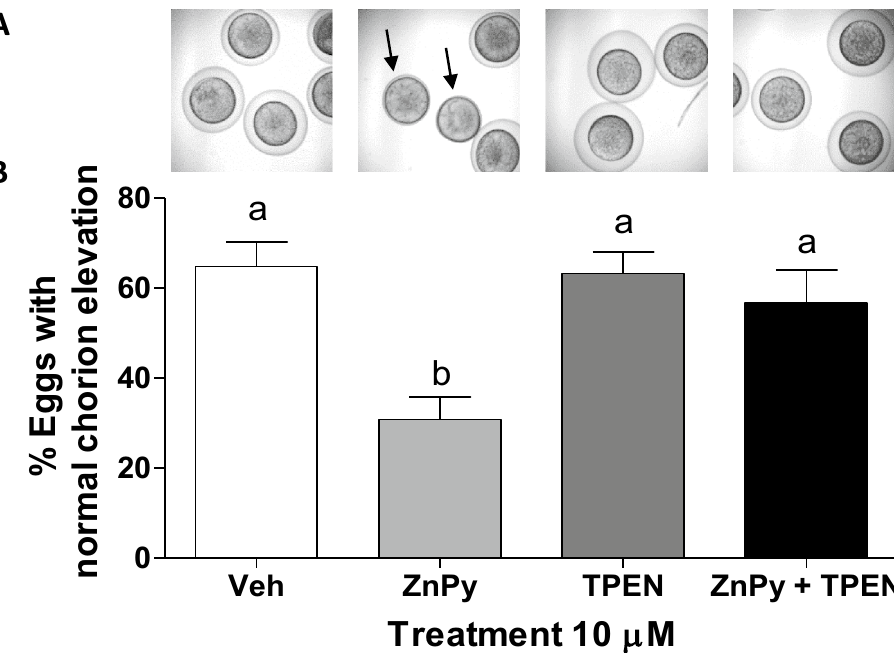
Figure 7. Effect of sustained zinc elevation on chorion elevation. (A) Representative micrographs of the effects of pre-treatment with zinc pyrithione (ZnPy) and TPEN on meiosis II-arrested eggs 10 min post-activation. (B) Quantification of ZnPy and TPEN-treated eggs that underwent chorion elevation post-activation. All data represents means ± SEM; n = 9–12. Each treatment was repeated in triplicate with similar results obtained for each, and the experiment was repeated with 3–4 fish. Significance was determined by one-way ANOVA with Bonferroni multiple comparison post-test. Different letters indicate significant differences between treatment groups in the post hoc test ( P <